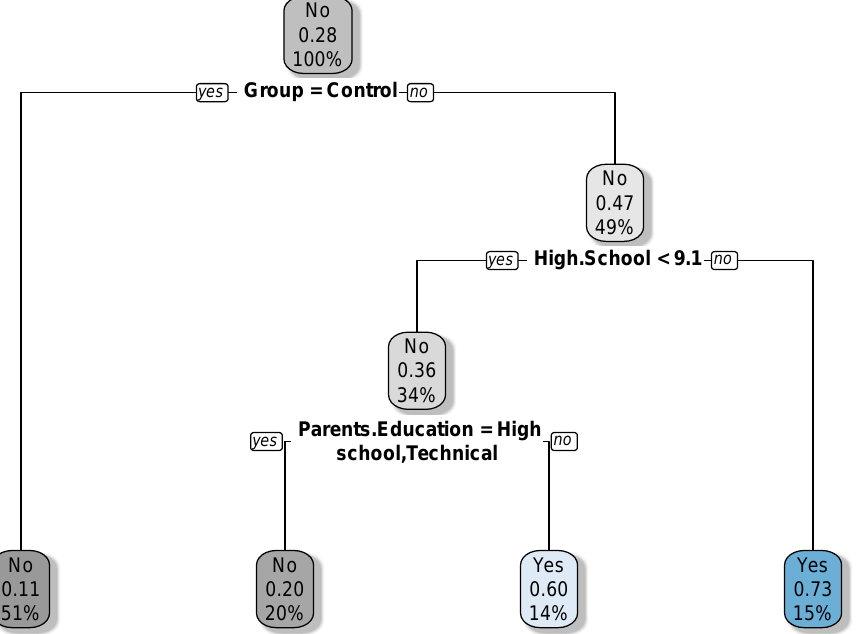
Figure 5. Fitted decision tree for explaining student passing (Yes) and failing (No) from demographics variables, previous grades and course motivation (items A1–A13, Table